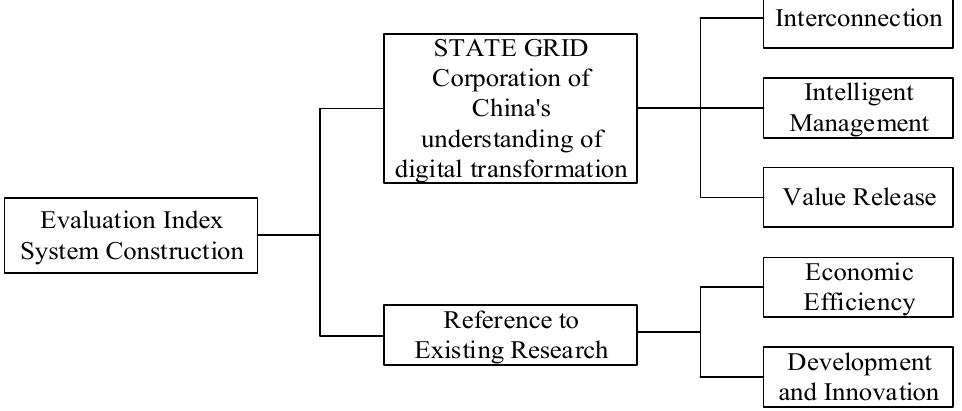
Figure 4. Digital project comprehensive evaluation index system construction process.